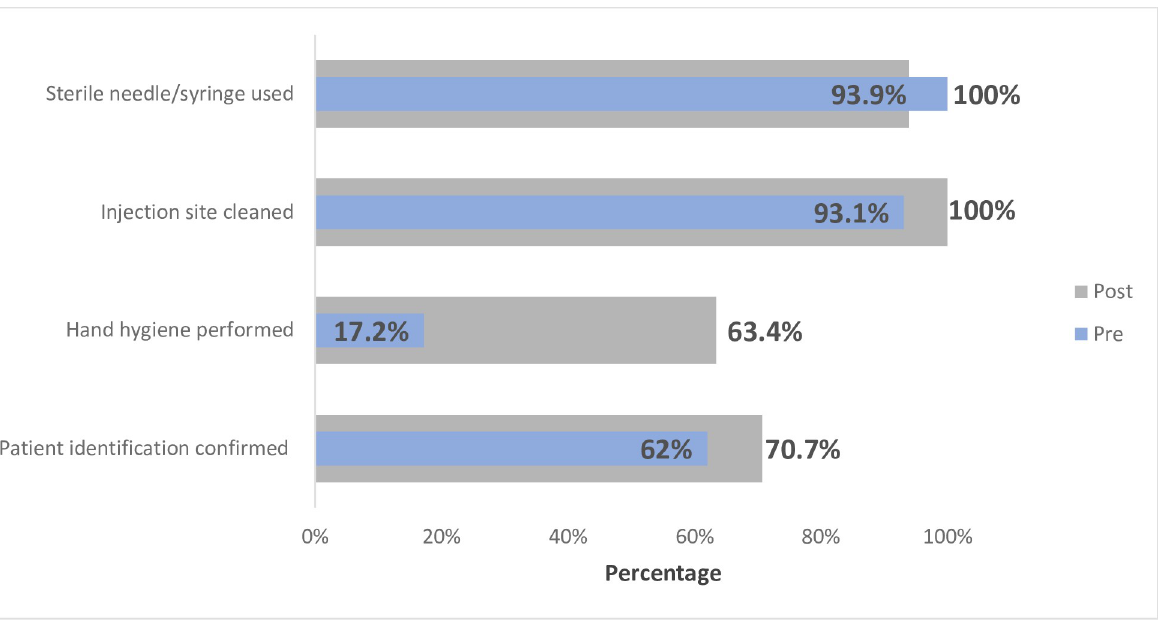
Fig 1. Combined pre and post training assessment of safe injection practices affecting patients (Diagnostic